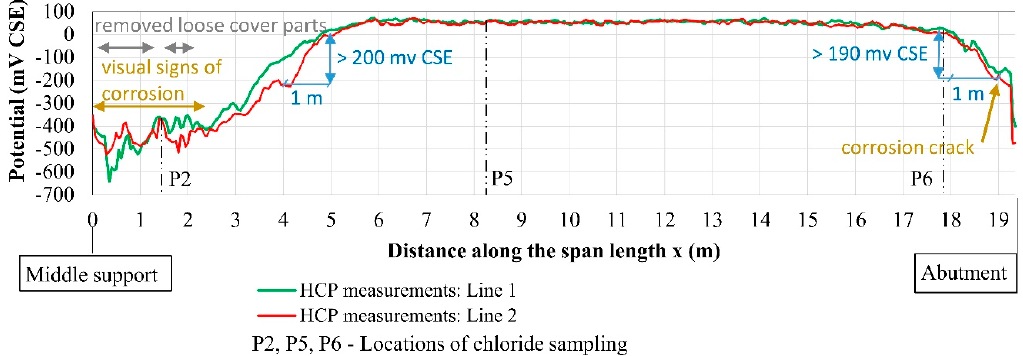
Figure 8. Distribution of half-cell potentials along the bottom surface of Girder 2.